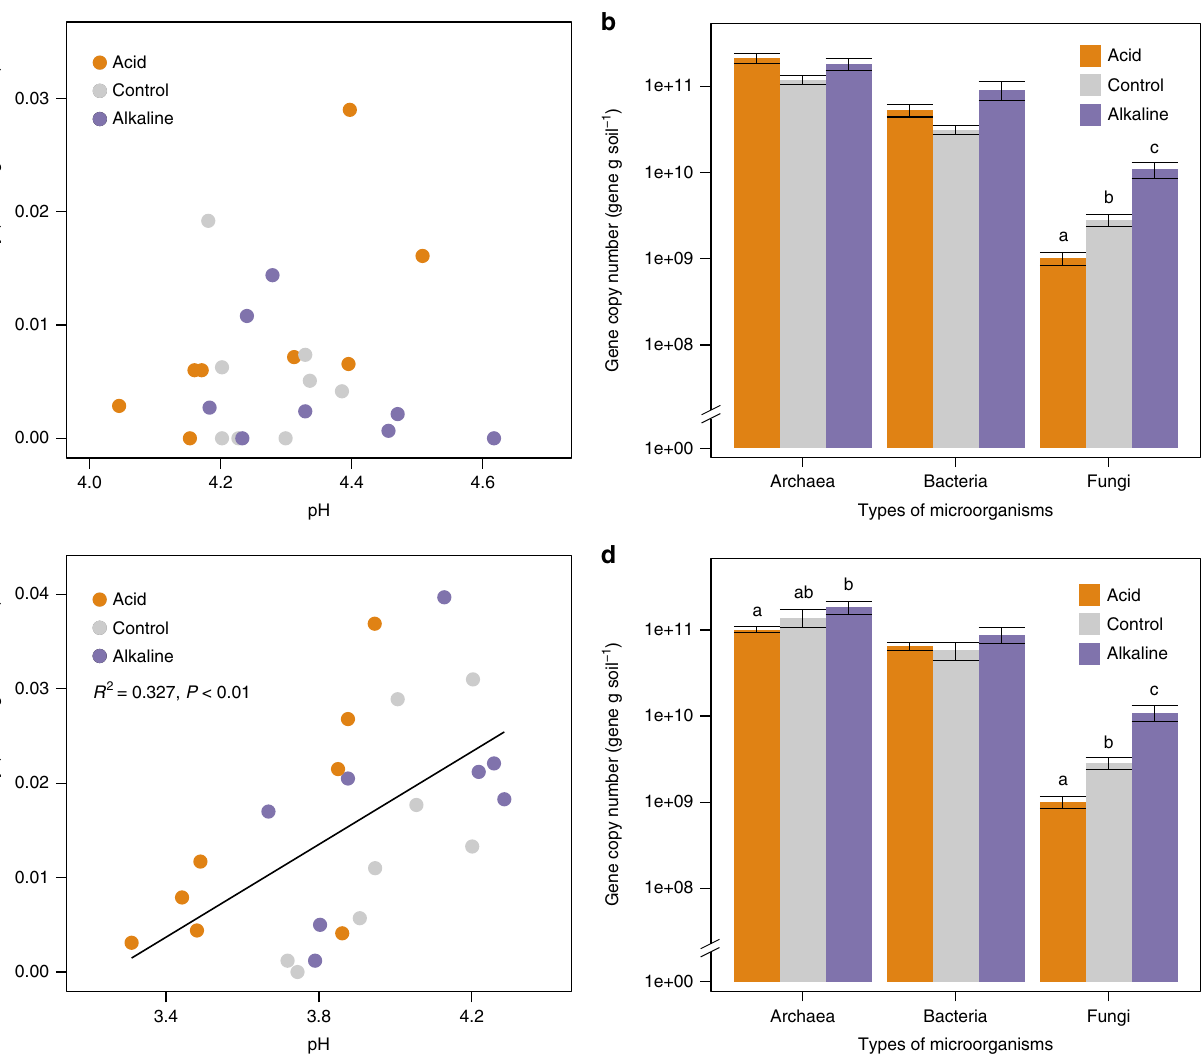
Fig. 3 pH effects on phenol oxidase and gene copy numbers in the fi eld. Relationship between pH and phenol oxidase activities in Migneint ( a ) and Peaknaze ( c ), and the gene copy numbers of bacteria, Archaea and fungi in different treatments in Migneint ( b ) and Peaknaze ( d )